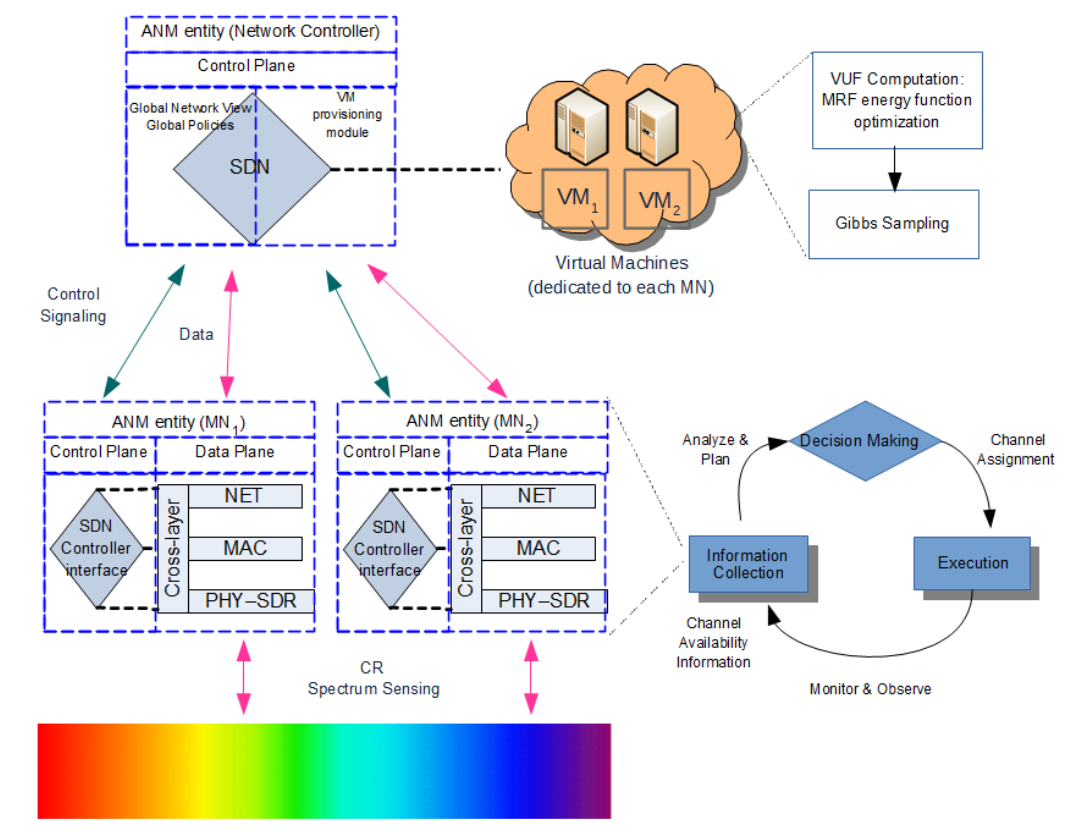
Figure 4. Generic ANMO-SDR